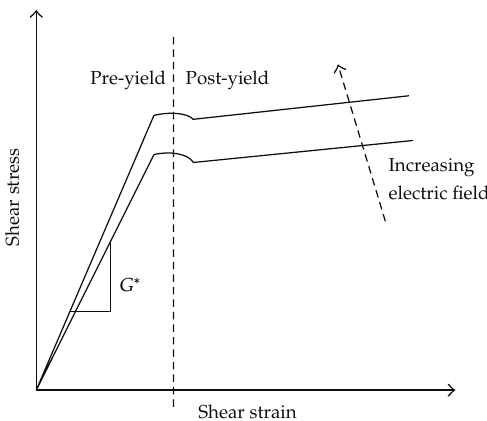
Figure 1: The shear stress-shear strain relationship of ER fluids.